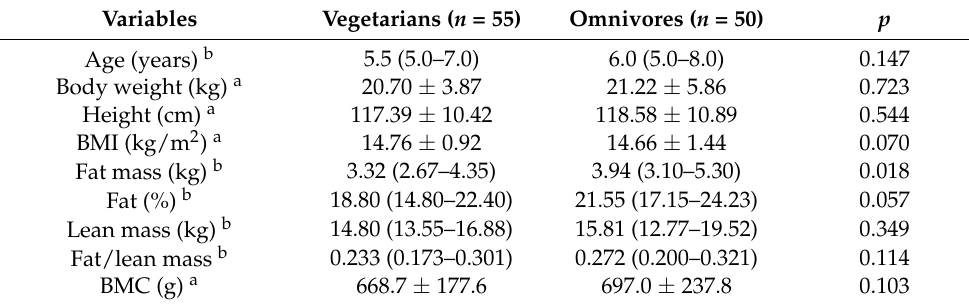
Table 1. Anthropometric parameters in children on vegetarian and omnivorous